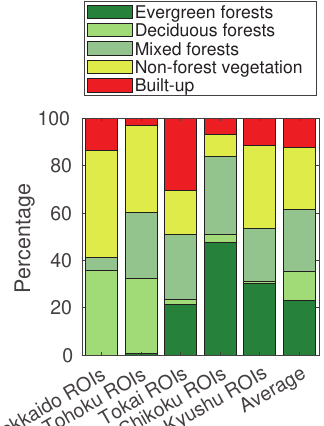
Figure 2. Overall average of each land cover category using individually averaged percentages of land cover type of the ROIs for each region based on the MCD12Q1C. The land cover type corresponding to evergreen forests (classes 1 and 2 in the IGBP classification system) was categorized as “Evergreen forests”. The types for deciduous forest (classes 3 and 4) were categorized as “Deciduous forests”. The type for mixed forests (class 5) was left as is. Other types with vegetation (classes 6, 8–12, 14) were categorized as “Non-forest vegetation”, and urban and built-up areas (class 13) were categorized as